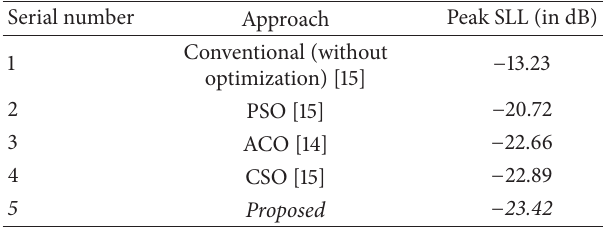
Table2: OptimizedpeakSLLfor10-elementlineararrayofExample 1